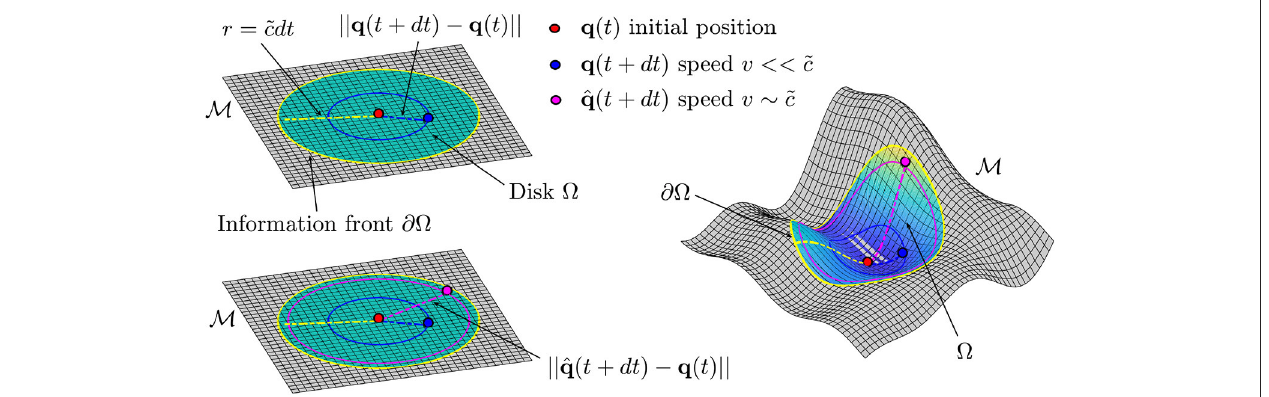
FIGURE 3 | Top left . Representation of the information front ∂(cid:127) propagating at speed v = ˜ c from the center of the disk (cid:127) on the flat plane M . The distance traveled by a point in the interval of time dt is given by || q ( t + dt ) − q ( t ) || and it will be always less than ˜ cdt (dashed yellow line), where ˜ c is the maximum speed of information. Bottom left . The analogous of the relativistic corrections are needed if we want to fully characterize the dynamics of a particle which is moving at speed v ∼ ˜ c Right. In the case of a generic manifold M the information front ∂(cid:127) will be the boundary of a region (cid:127)